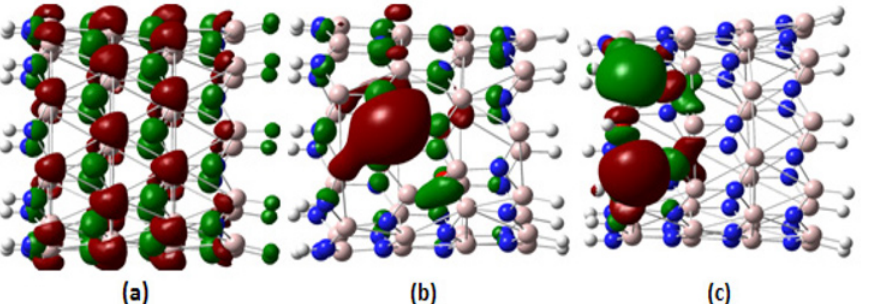
Figure 3. HOMO-LUMO are plotted for a: pristine (10, 0), b: Model.1, c: Model.2 of AlNNTs.